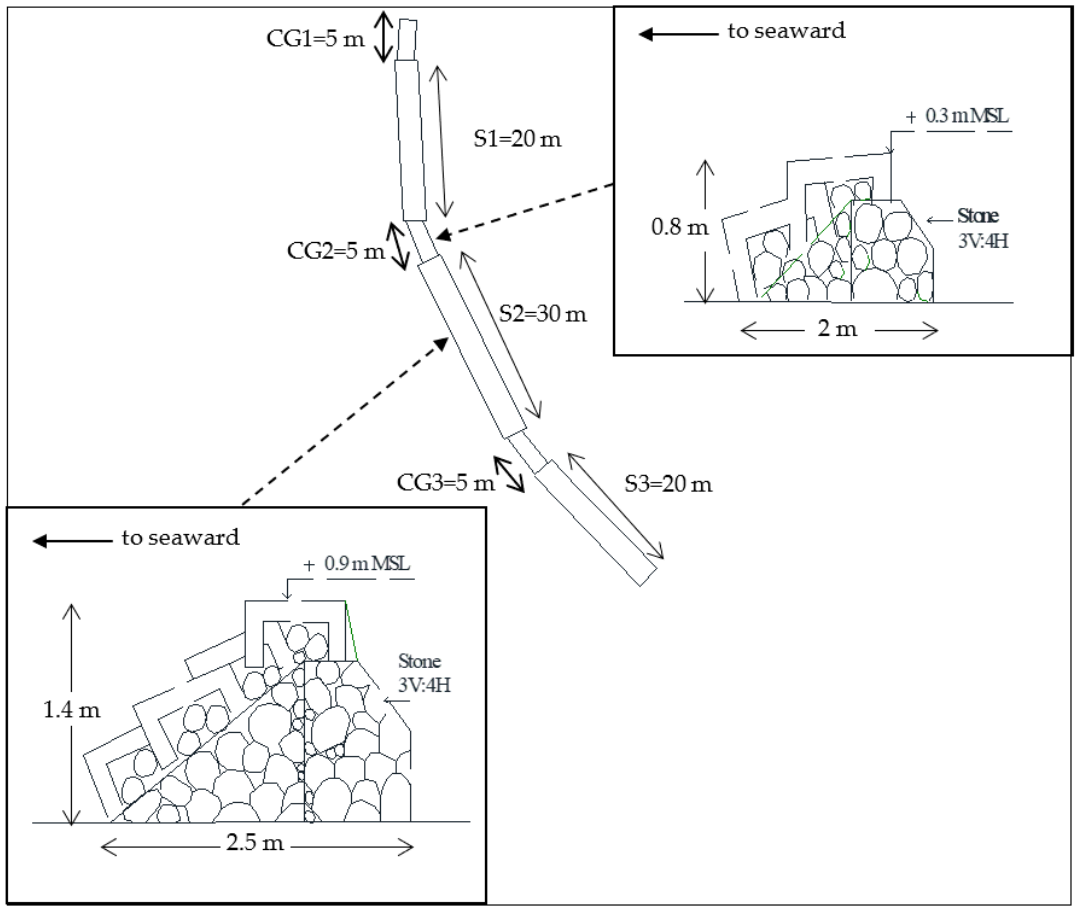
Figure 2. Schematic of detached breakwater structure.